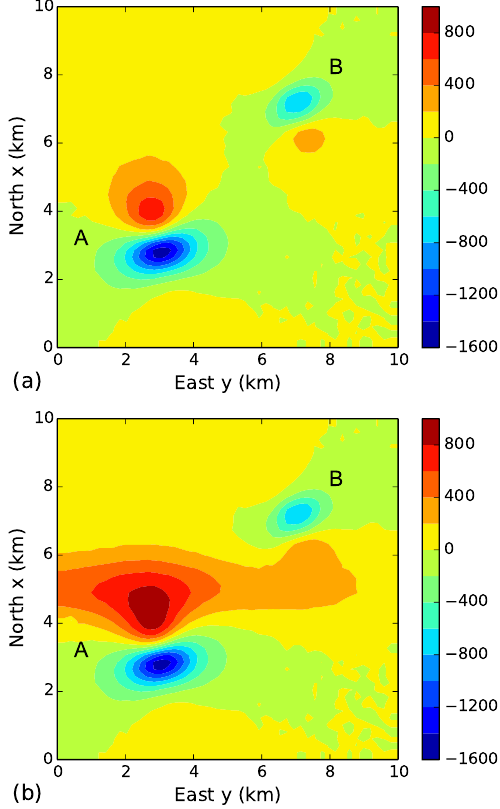
Figure 3. Validation test and robustness against interfering anoma- lies. (a) Synthetic noise-corrupted total field anomaly produced (nT) by a sphere and a rectangular prism. (b) Synthetic anomaly shown in (a) plus produced by an interfering anomaly. The anoma- lies produced by the sphere and prism are pinpointed as (A) and (B),